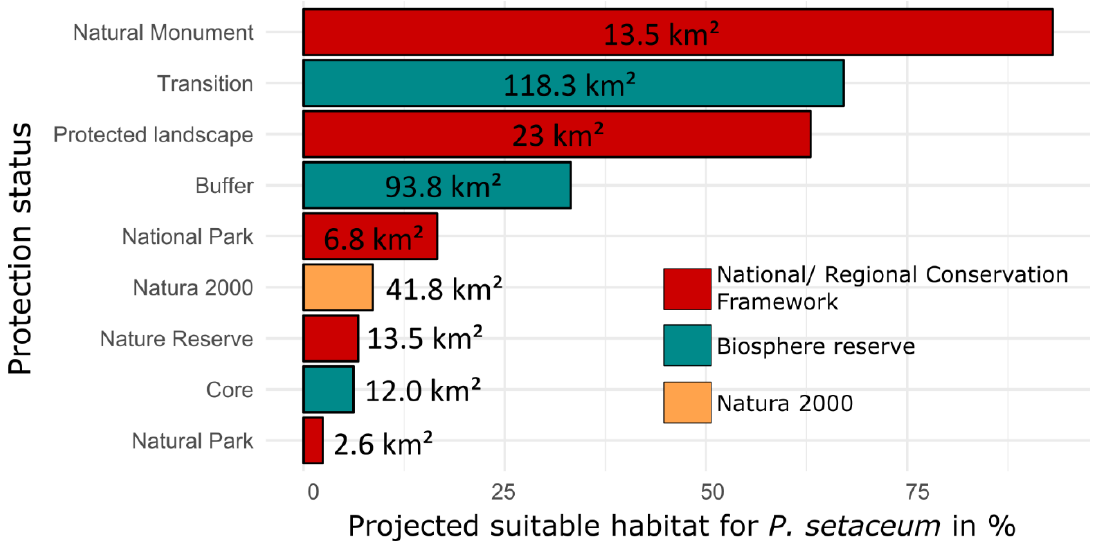
Figure 7. Projected suitable habitat for P. setaceum in protected areas on La Palma in coverage percent and area in km².